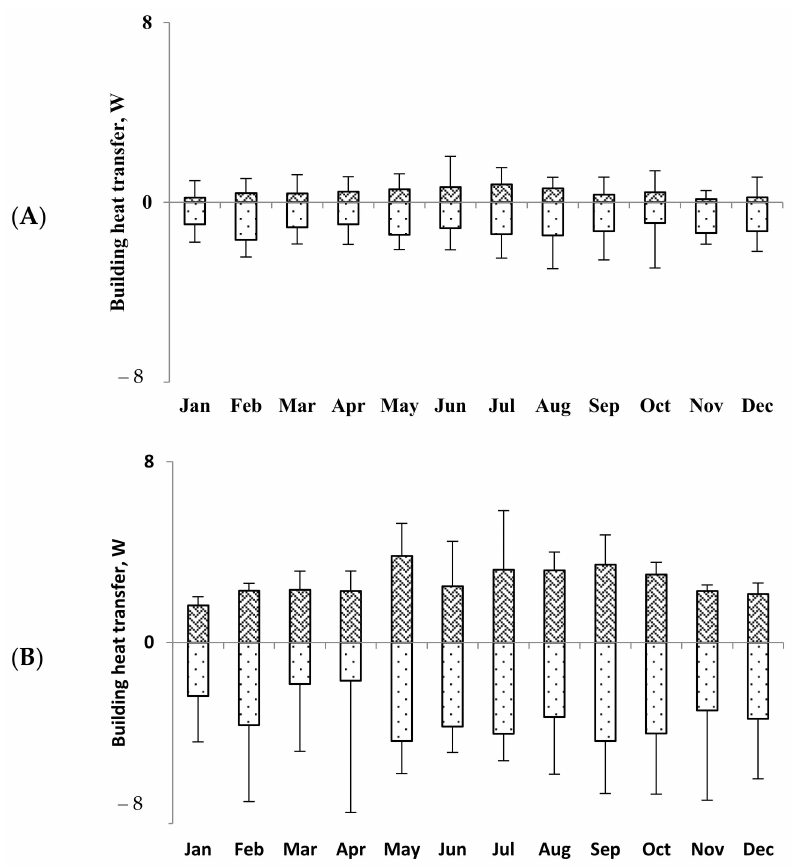
Figure 9. Building heat transfer of ( A ) underground room and ( B ) aboveground